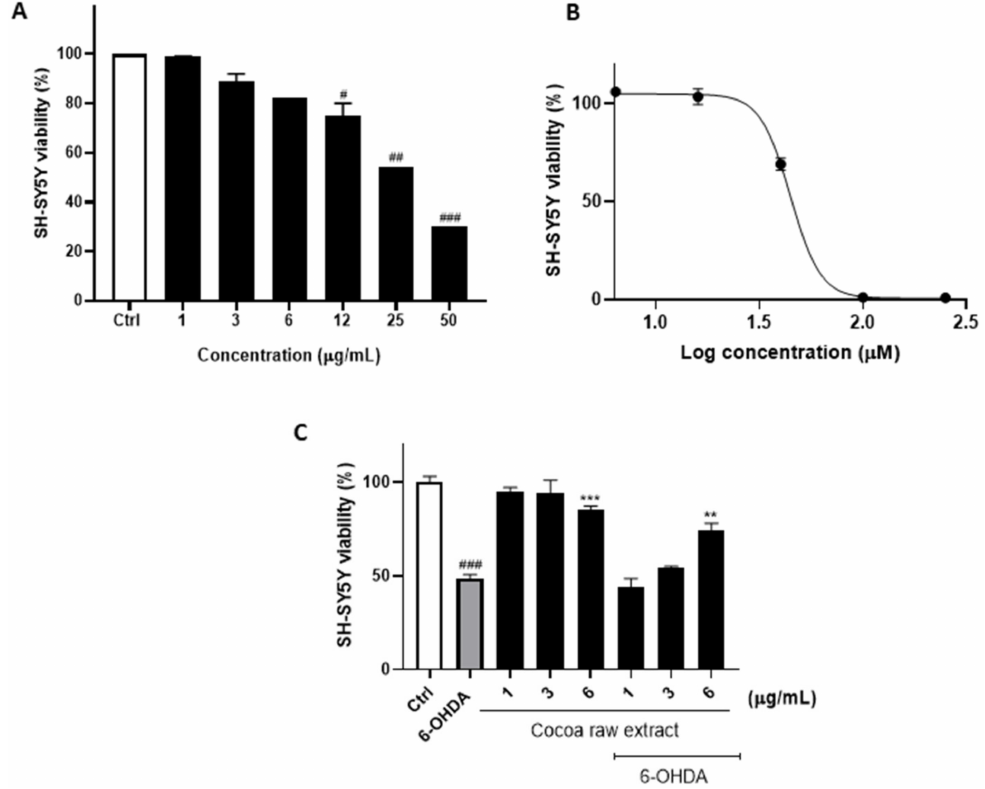
Figure 1. Cell viability was examined by the PB assay. ( A ) SH-SY5Y cells were exposed to the raw cocoa extract in the range of 1–50 µ g/mL. ( B ) 6-OHDA EC 50 was calculated using GraphPad Prism 8.0 software by nonlinear regression of dose-response inhibition. ( C ) Neuroprotective effect of the cocoa raw extract against 6-OHDA-induced cytotoxicity. The viability variations were calculated as percentage of viable cells in treated cultures compared to untreated ones. Results are showed as mean ± standard deviation (SD) from three independent experiments. #, ## and ### denote respectively p < 0.05, p < 0.01 and p < 0.001 vs. Ctrl; **, *** denote respectively p < 0.01 and p < 0.001 vs.